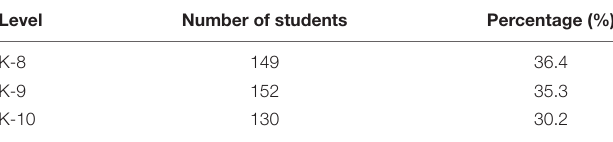
TABLE 1 | Distribution of students by